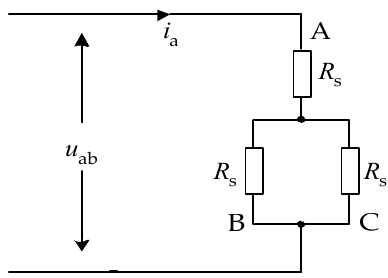
Figure 2. Equivalent circuit of the IM under a DC-excited test, where u ab is the inverter output phase-phase voltage and i a is the stator current through the phase-A. The stator resistance for the three phases is assumed the same in the test.